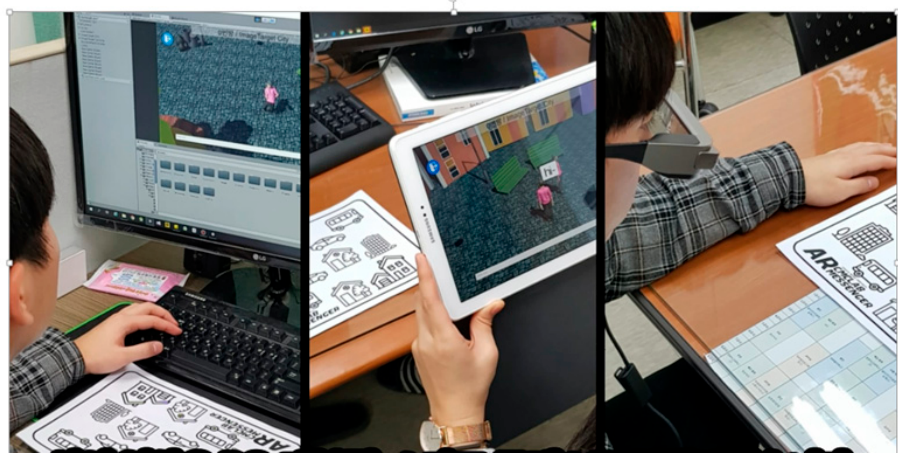
Figure 5. Messenger execution on a variety of devices.